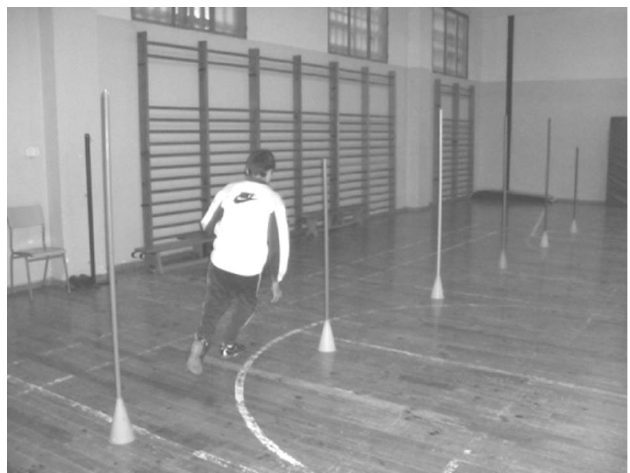
Figure 1. Agility